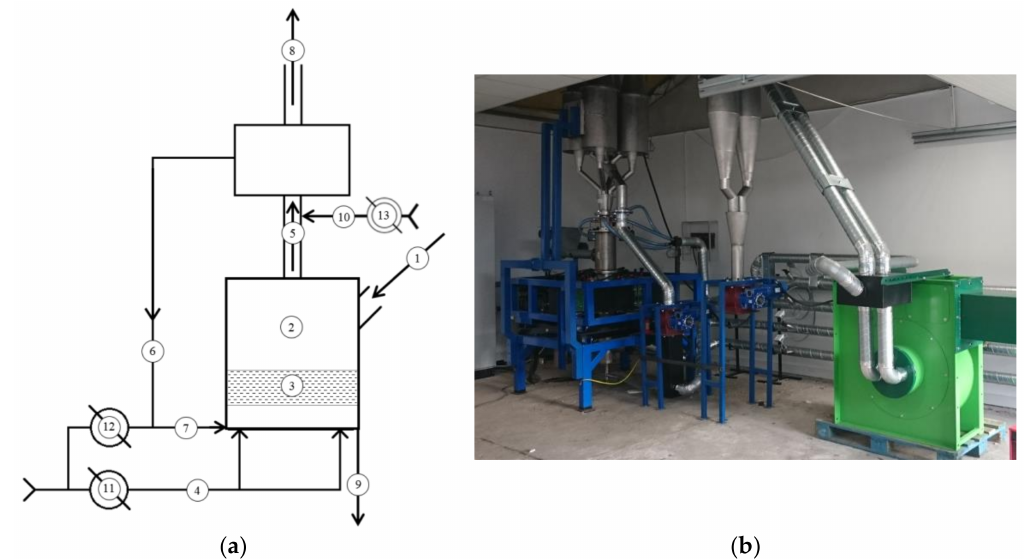
Figure 3. Dry grinding and classification circuit: ( a ) Idea of the circuit: 1-feed stream, 2-mill working chamber, 3-working area with ferromagnetic rods, 4-main transport air stream, 5-mills output stream, 6-recycle material stream, 7-recycle material with transport air stream, 8-final product stream, 9-coarse ungrindable particles stream, 10-additional air stream for the classifier, 11–13-air dumping flaps; ( b ) Exemplary installation with the D200 electromagnetic mill (EMM).